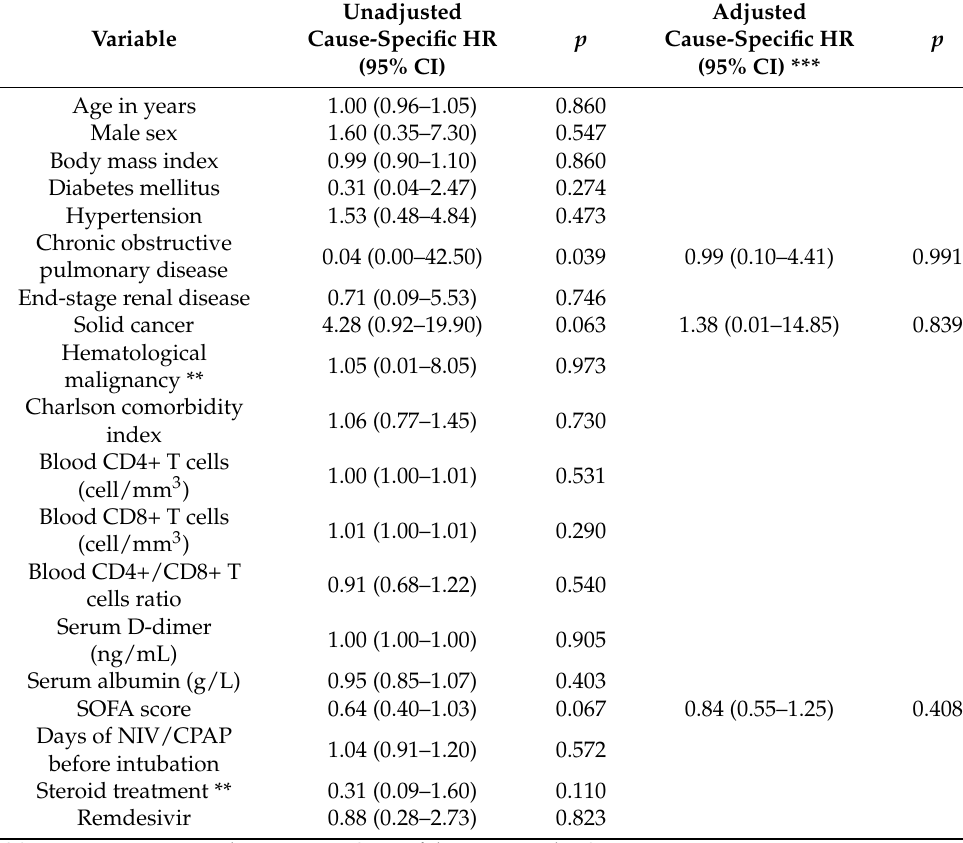
Table 2. Univariable and multivariable analyses of potential predictors of HSV-1 reactivation *.